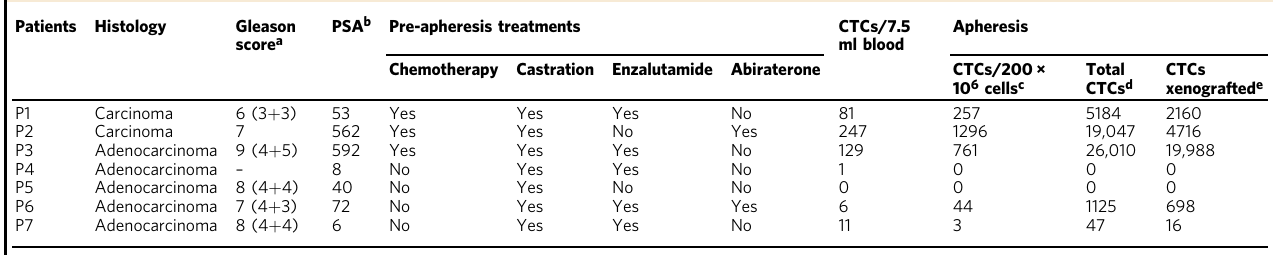
Table 1 Characteristics of mCRPC patients and apheresis